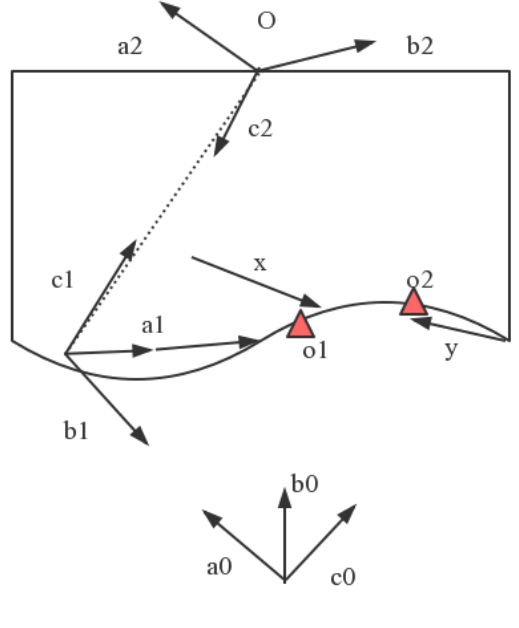
Fig. 3 Flow chart of experimental